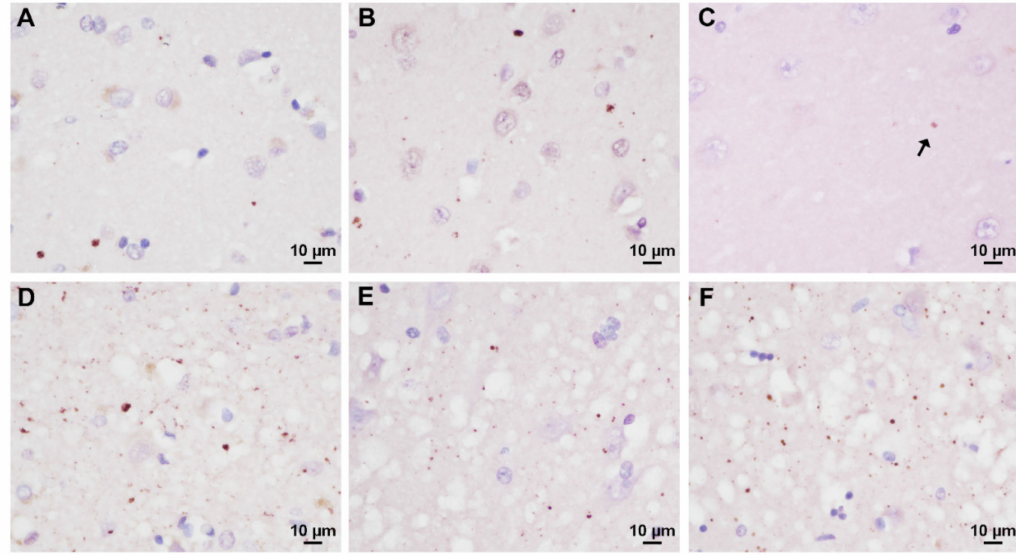
Figure 3. Ubiquitin immunoreactivity in the most common sCJD subtypes. In the neocortex of sCJD VV2, dot-like ubiquitin deposits are sparse and rare in the superficial layers lacking significant spongiform change ( A ), while they are abundant in the deep layers where spongiform change is florid ( D ). Overall, the extent of ubiquitin deposition in the cerebral cortex is lower in sCJD MM(V)1 than in the VV2 subtype ( B ). In the CA1 hippocampal sector, ubiquitin immunoreactivity is almost absent in sCJD MM(V)1 ( C ) the arrow indicates a tiny dot), widespread and prominent in VV2 ( F ), and of intermediate intensity in MV2K ( E ). Remarkably, spongiform change is more pronounced in sCJD MV2K and VV2 (E and F, respectively) than in MM(V)1 cases